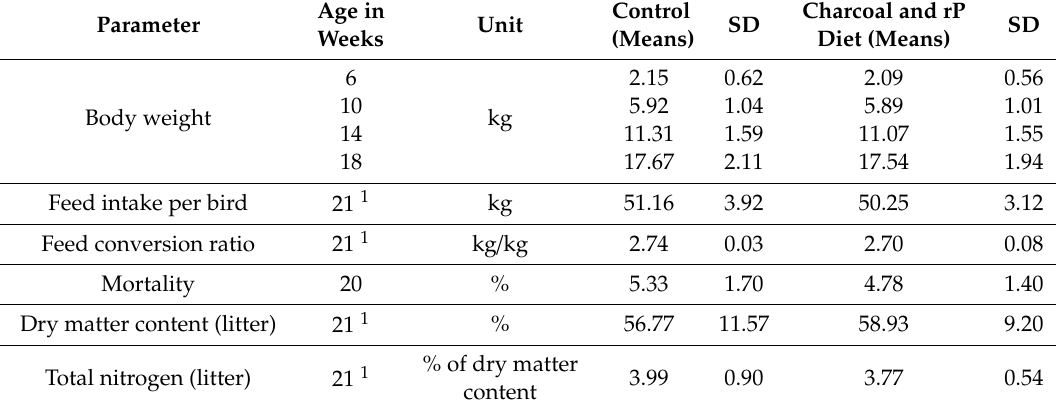
Table 7. Performance results of control and charcoal + protein-reduced (rP) diets of Experiment 2, means and standard deviations (SD) of the di ff erent parameter of the BUT6 turkey toms. Body